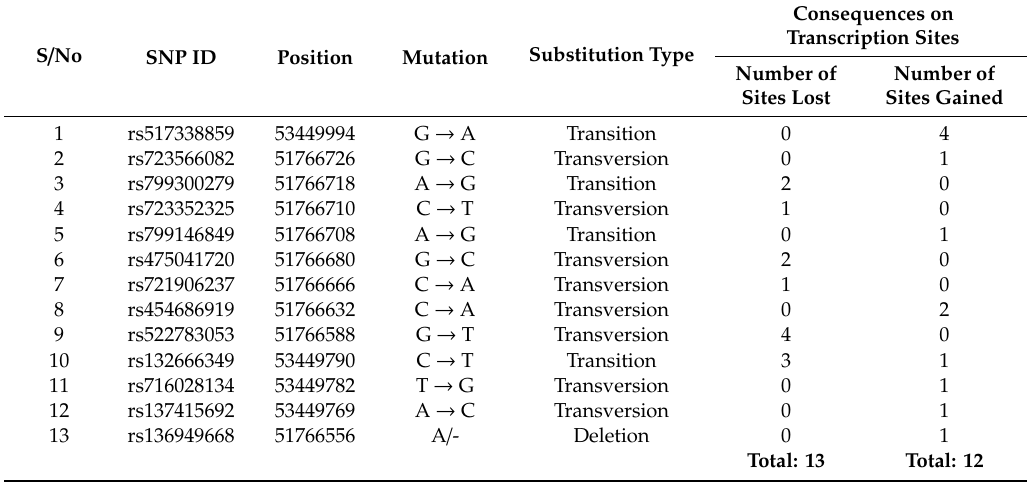
Figure 2. SNP overlap of the CD14 gene promoter between White Fulani and N’Dama cattle. Forty -one SNPs were concomitant between White Fulani and N’Dama cattle while 13 were unique for N’Dama. No unique SNPs were identified for White Fulani. Table 2. N’Dama-specific single nucleotide polymorphisms identified at the CD14 gene promoter